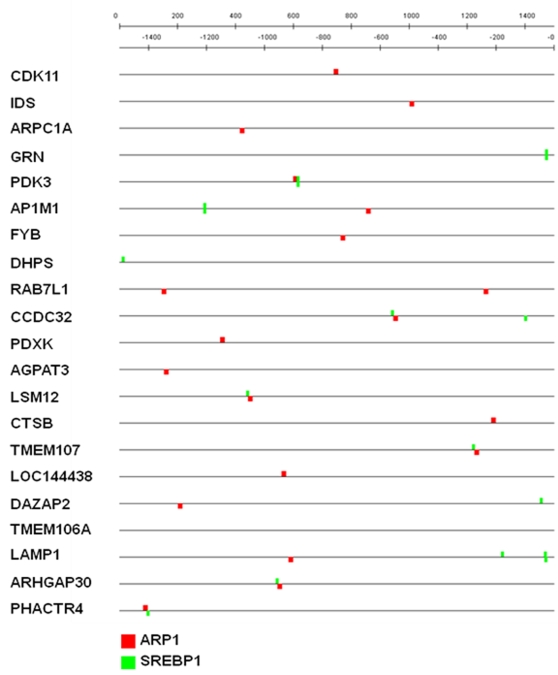
SREBP1 binding sites in CTDGs.The 1.5 kb sequences upstream of the first exon of genes are indicated (both strands). Predicted binding sites on both DNA strands are indicated.